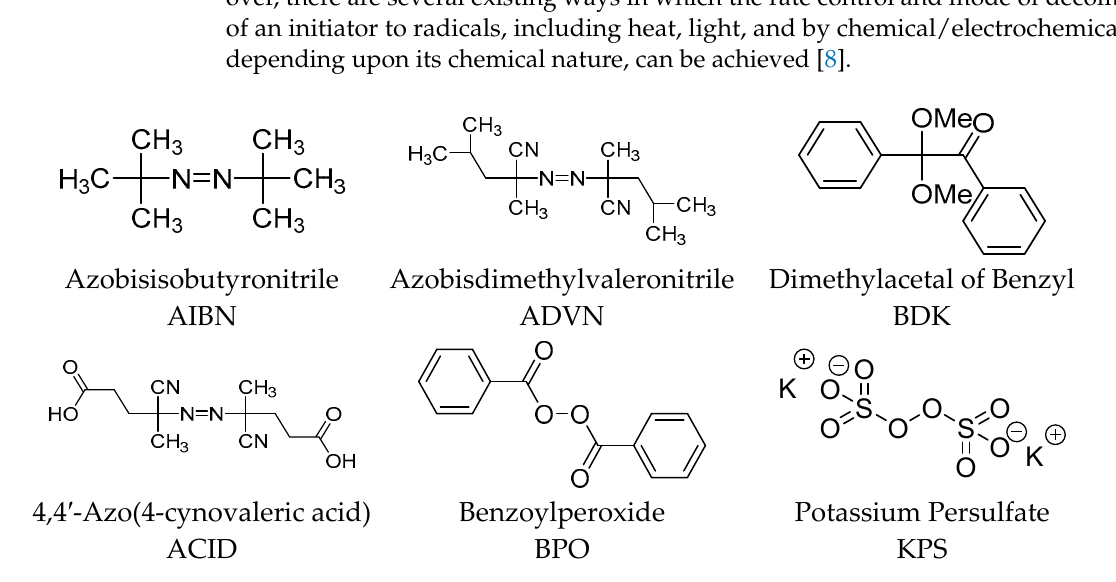
Figure 5. Chemical structures of commonly used cross-linking agents in molecular imprinting technique.